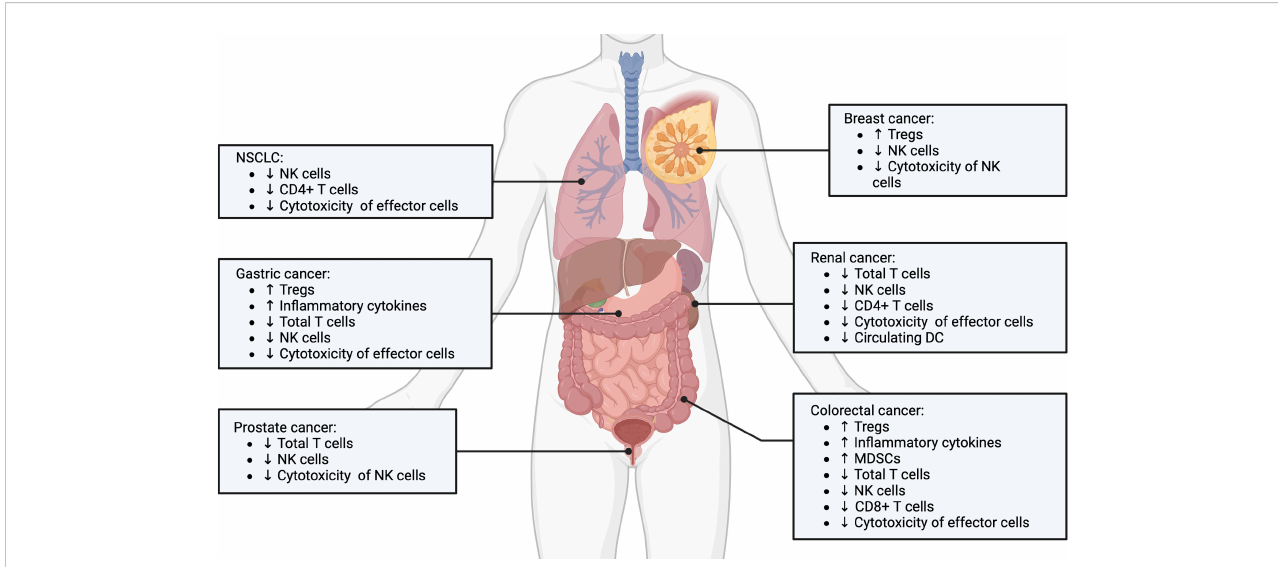
FIGURE 1 Postoperative immunosuppression in various solid cancer types. Postoperative immunosuppression is a stress and in fl ammation induced response that is observed across many types of solid tumors, including non-small cell lung, gastric, prostate, breast, renal and colorectal cancers. The underlying cellular mediators involve expansion of pro-tumorogenic regulatory immune cells and dysregulation of tumor-targeted effector immune cells. Created with